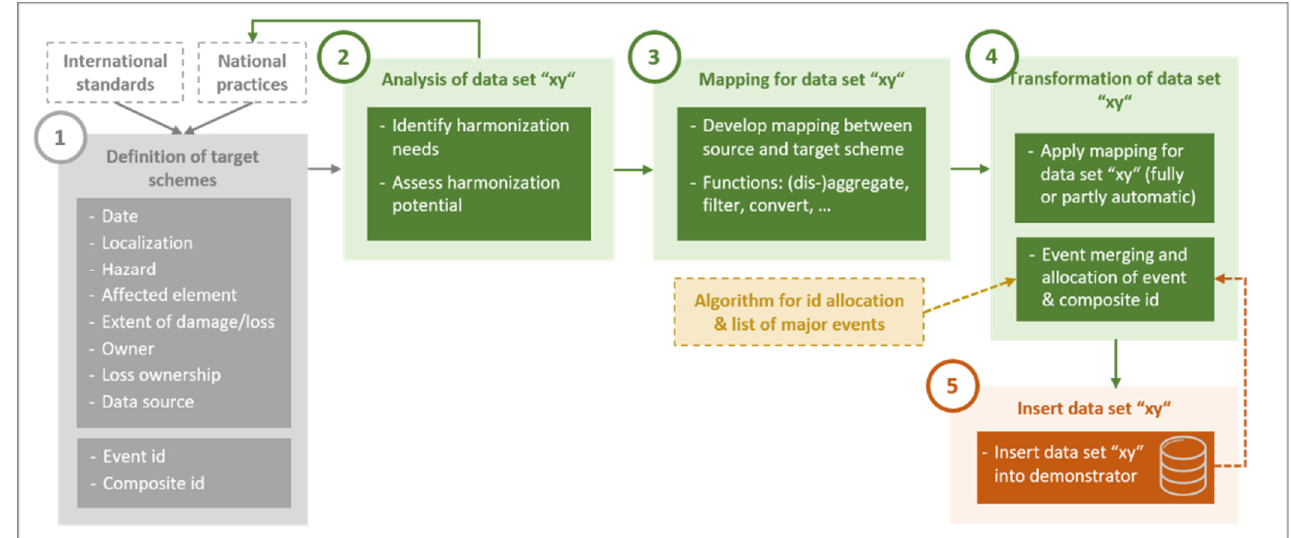
Figure 2. The CESARE data harmonization procedure.